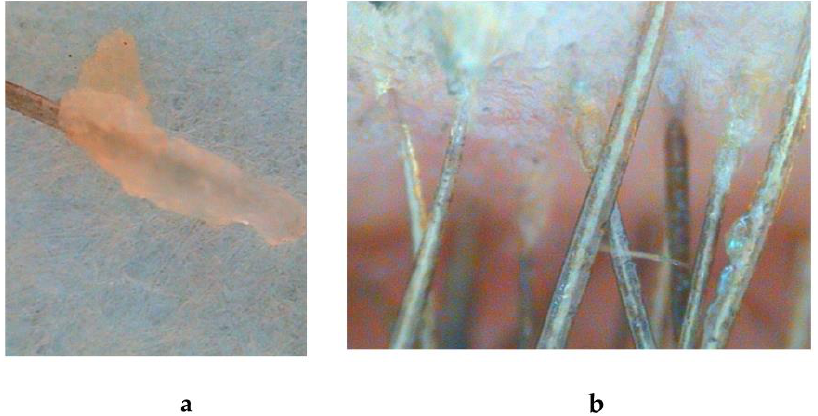
Figure 3. Determination of the hair follicle diameter and lipid/water mantel conditions: ( a ) hair root/follicle; ( b ) lipid mantel and hydration conditions were performed under ×200 magnification.